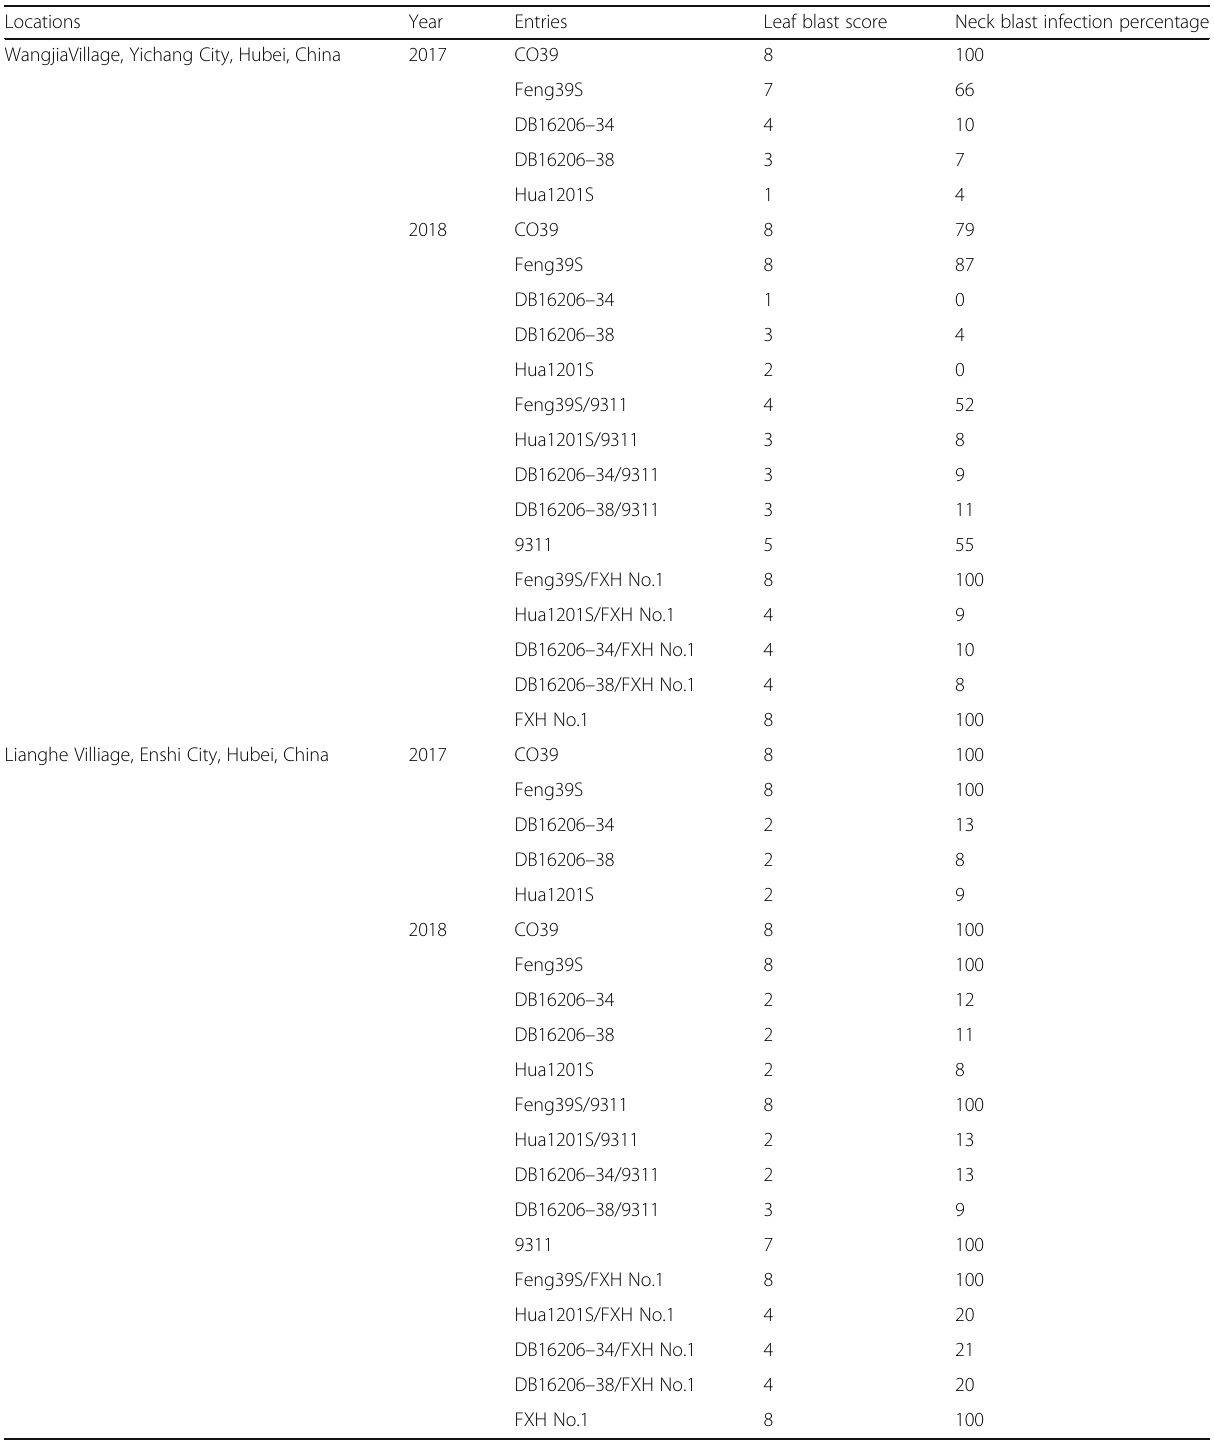
Table 3 Performance for leaf and neck blast in breeding PTGMS lines, parents, and their hybrids in blast epidemic fields